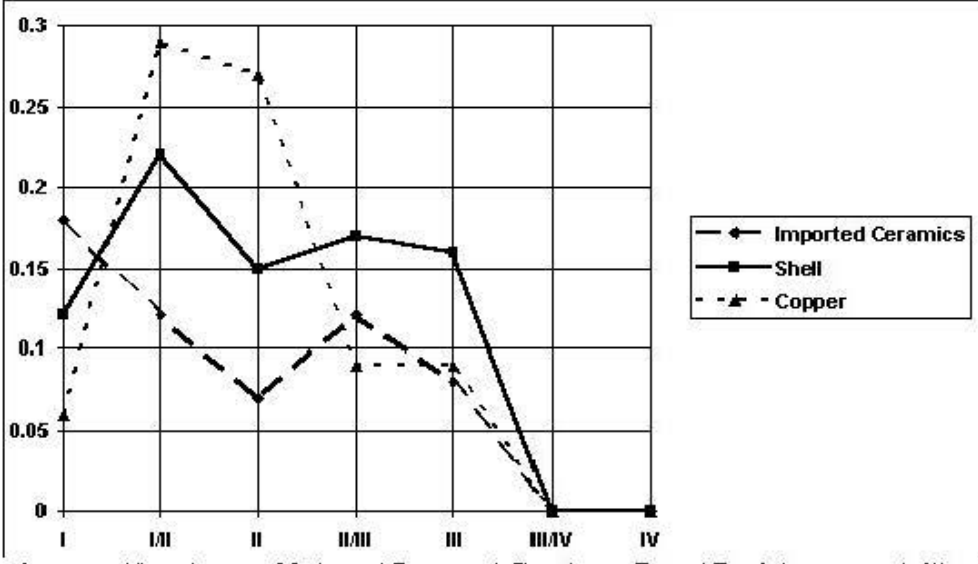
figure 5. Abundance of Selected Imported Gootl~ per Dated Burial at